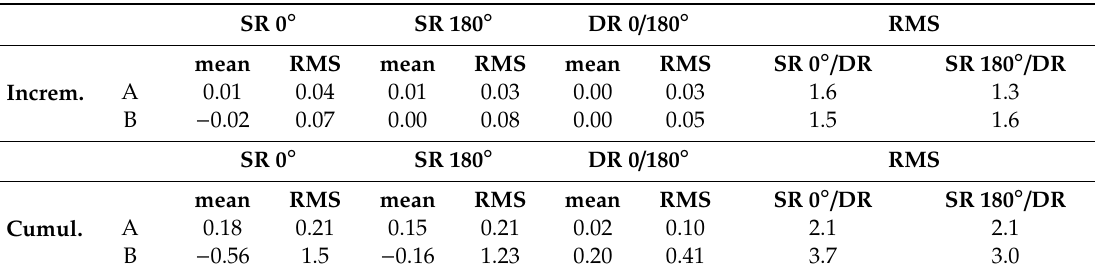
Table 6. Summary of the results obtained in Section 2 (91 measures). In the first part are the incremental displacements and in the second part is the cumulative displacement. SR 0 ◦ SR 180 ◦ DR 0 / 180 ◦ RMS Increm.